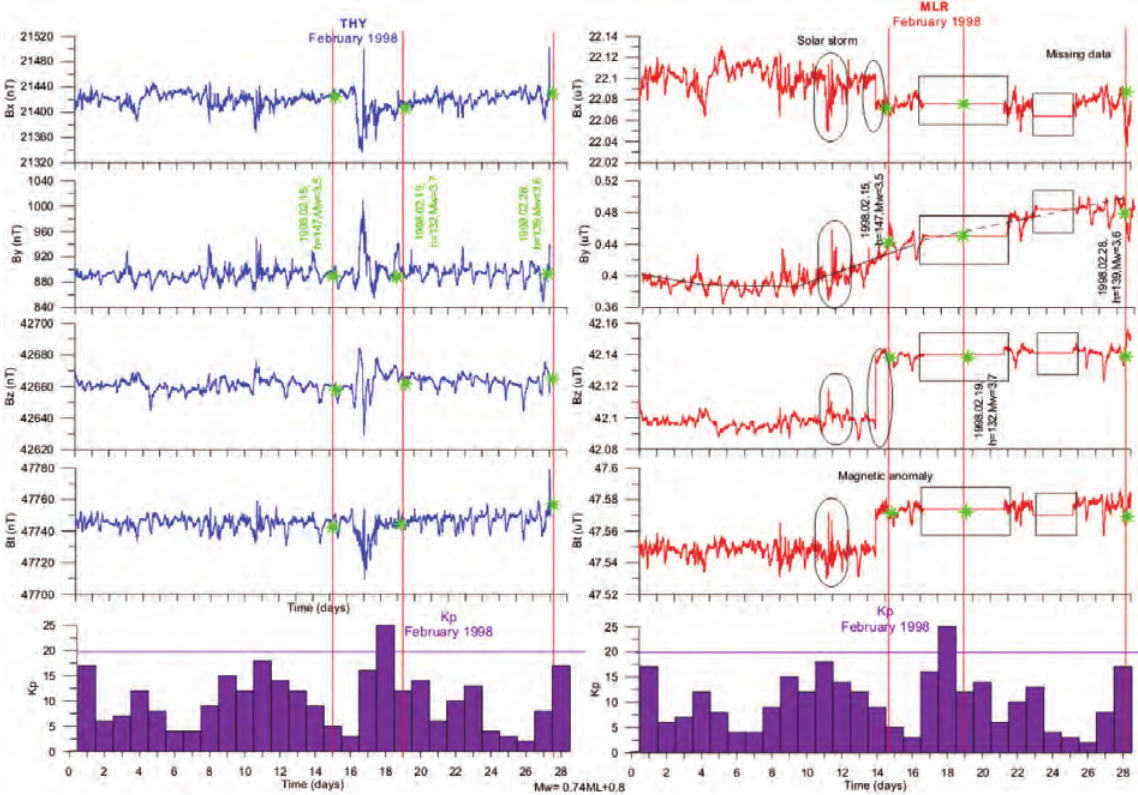
Figure 4. The V-shaped anomaly of By started on January 23, 1998 (see Figure 2), and continued until February 15, 1998, when the prior value of By was restored. One day before restoration, a step-change occurred on the Bx and Bz components. An earthquake with magnitude Mw = 3.5 (h = 147 km) occurred on February 15, 1998. Between February 17 to 21, 1998, there was a data gap. The same situation is seen for February 23 to 25,